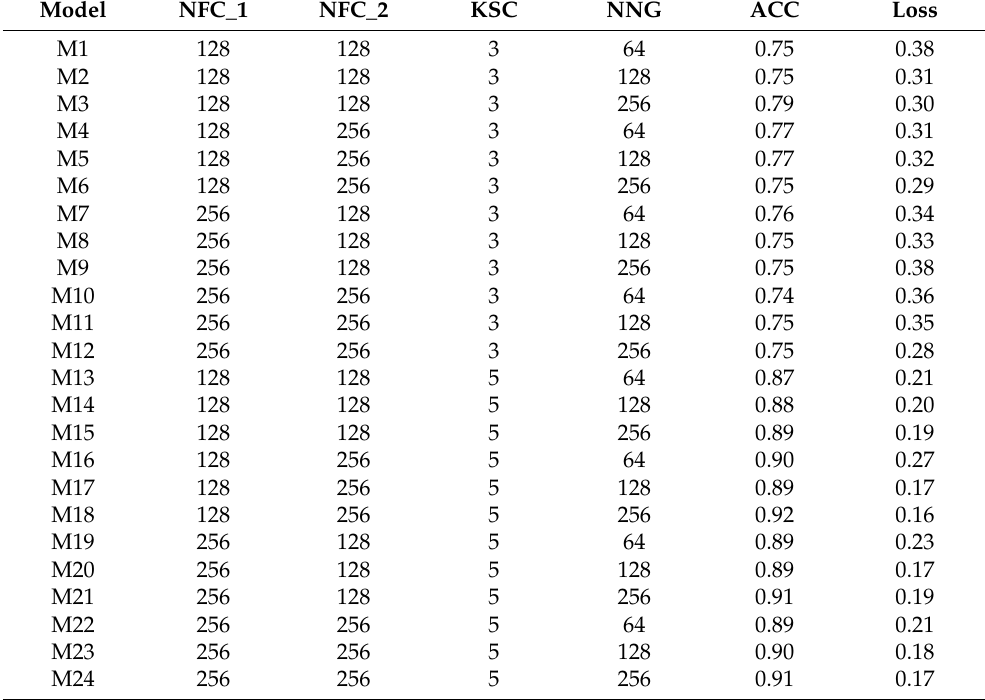
Table 2. Tuning of network parameters.